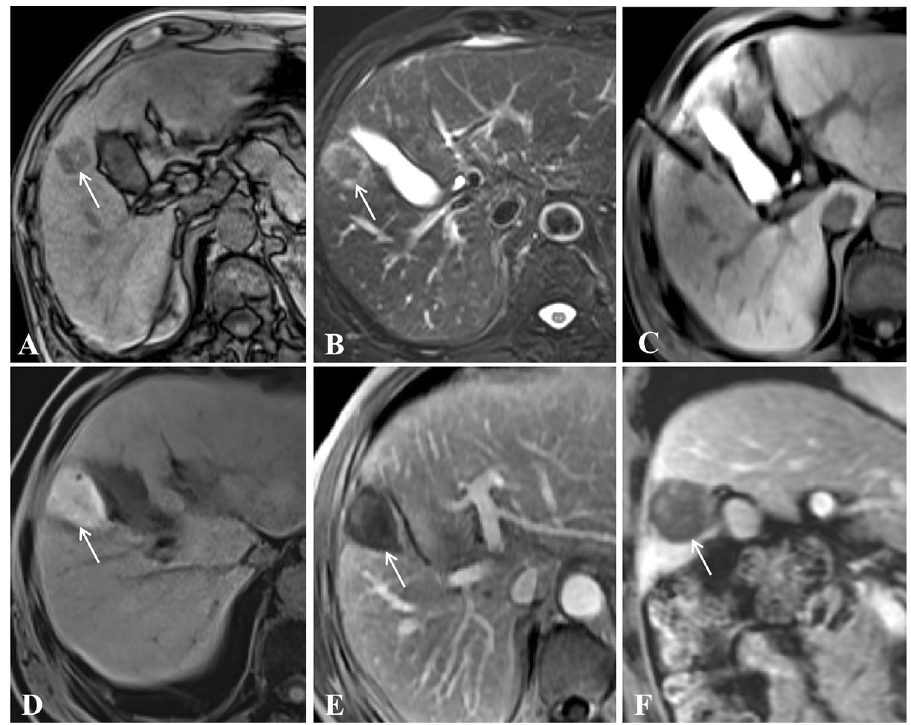
Figure 2. A 56-year-old man with rectal carcinoma and liver metastasis close to the gallbladder at segment 5. ( A , B ) Pretreatment MR showed a small lesion (diameter = 2.2 cm) on T1WI ( A ) and T2WI ( B ); ( C ) Lesion was punctured by a microwave applicator on cross section; ( D ) T1WI showed that the ablation focus was ellipsoidal with high signal; ( E , F ) Enhanced MR showed that the focus was completely ablated at the 1-month evaluation in cross and sagittal sections (white arrow).